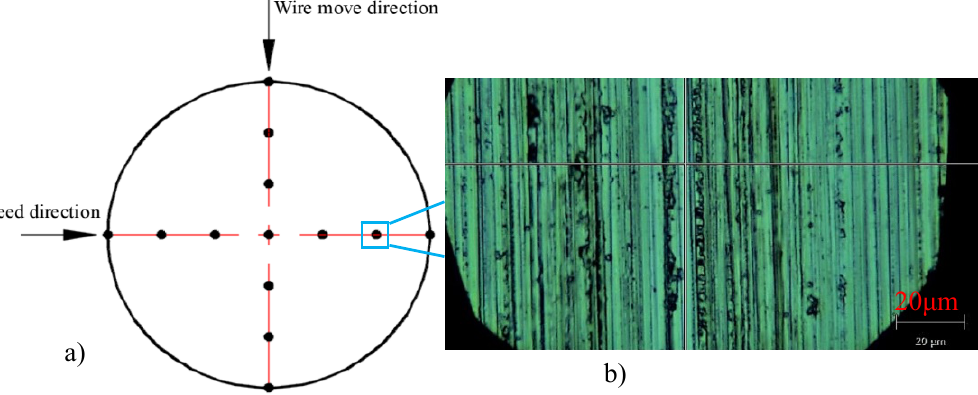
Figure 4. Schematic diagram of distribution for characterized points and the sliced surface topography. ( a ) Distribution of characterized points; ( b ) the sliced surface topography of silicon wafer.